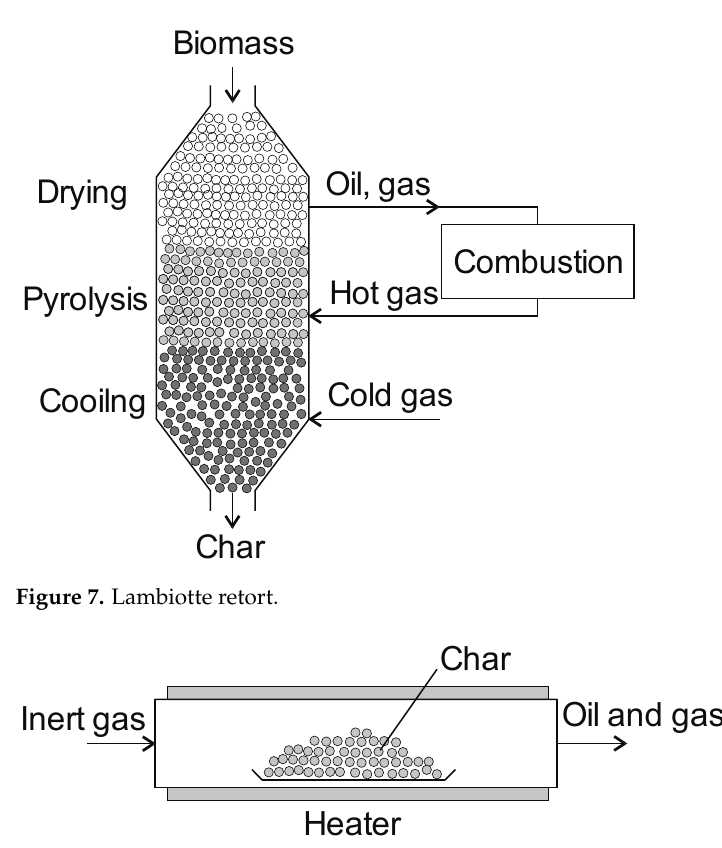
Figure 8. Fixed bed reactor for batch processes.